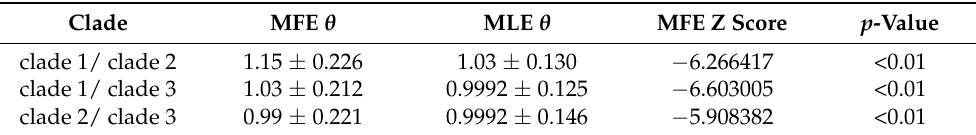
Figure 6. Phylogenetic relationships, conserved domains and motifs analysis of galectins of 12 fig wasps. ( A ) The amino acid sequences of galectins of 12 fig wasp species (Table S1), D. melanogaster (Dmel), A. mellifera (Amel), N. vitripennis (Nvit) and P. puparum (Pp) were used to construct the maximum likelihood tree, and the optimal model was JTT+R9. The galectins were clustered into three clades. ( B ) The distributions of conserved motif in galectin genes. 10 motifs were displayed in different colored boxes. ( C ) The domains of galectin genes. Each clade had specific domain features. Table 3. Functional divergence analysis of three clades of galectin genes.